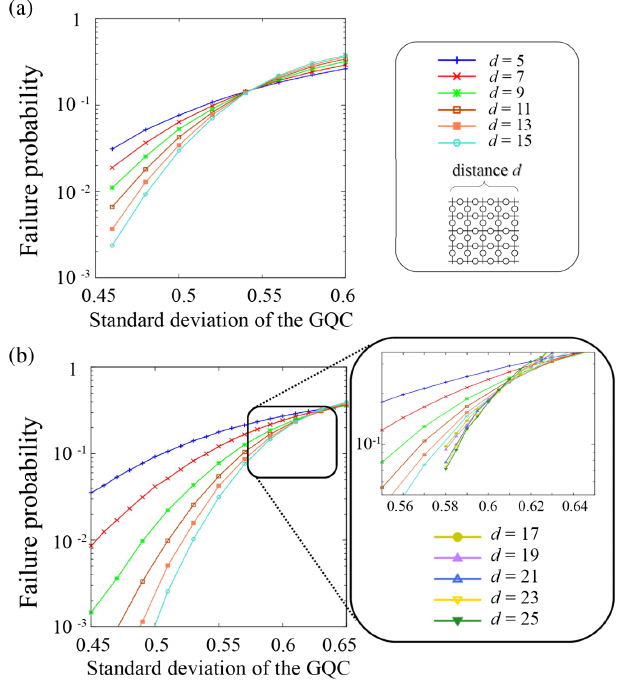
FIG. 2. Simulation results for the logical error probabilities of the surface code with ideal syndrome measurements using (a) the digital QEC and (b) the analog QEC for several distances d , which are the size of the 3D cluster state. The simulation results for the digital QEC are obtained from 50 000 samples. The simulation results for the analog QEC are obtained from 50 000 samples (for d ¼ 5 – 15 ) and 10 000 samples (for d ¼ 17 – 25